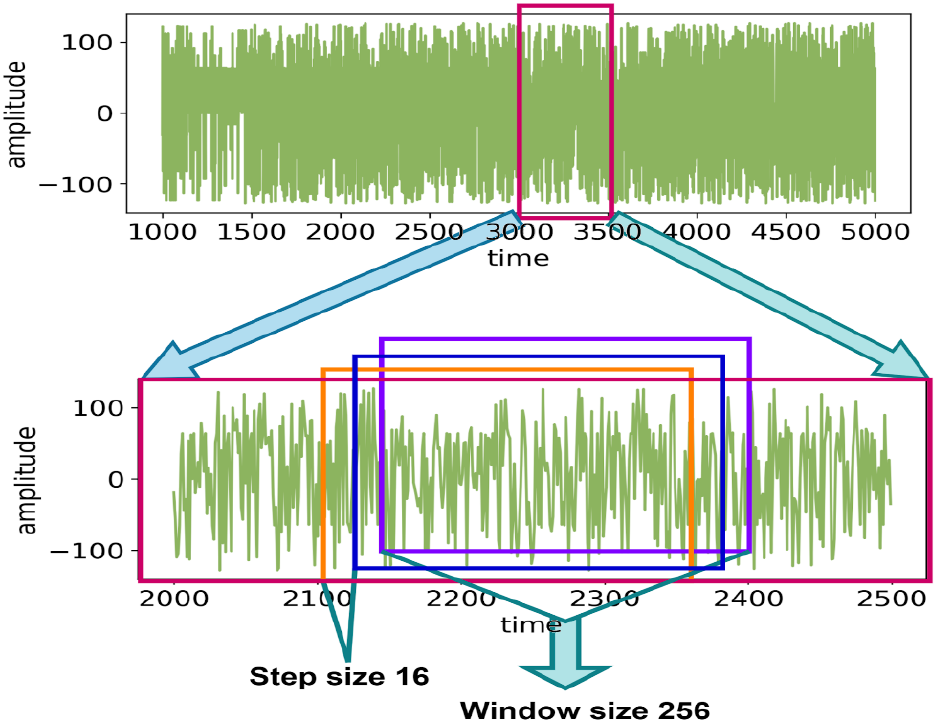
Figure 4. Sliding the window using FFT.